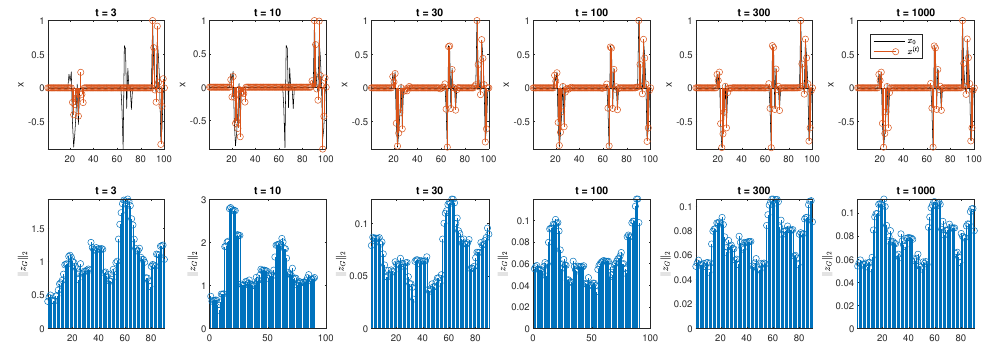
Figure 4 Trajectory of primal variable and dual group norms. Here we investigate RP-CGM where θ = 1 / 2, ρ = 0 . 01, and p = 2. For stability, t 0 = 100. The ground truth x 0 contains 3 “pulses”, e.g. areas where it is nonzero, and the goal is to fit x ( t ) to x 0 , using this group structure prior.